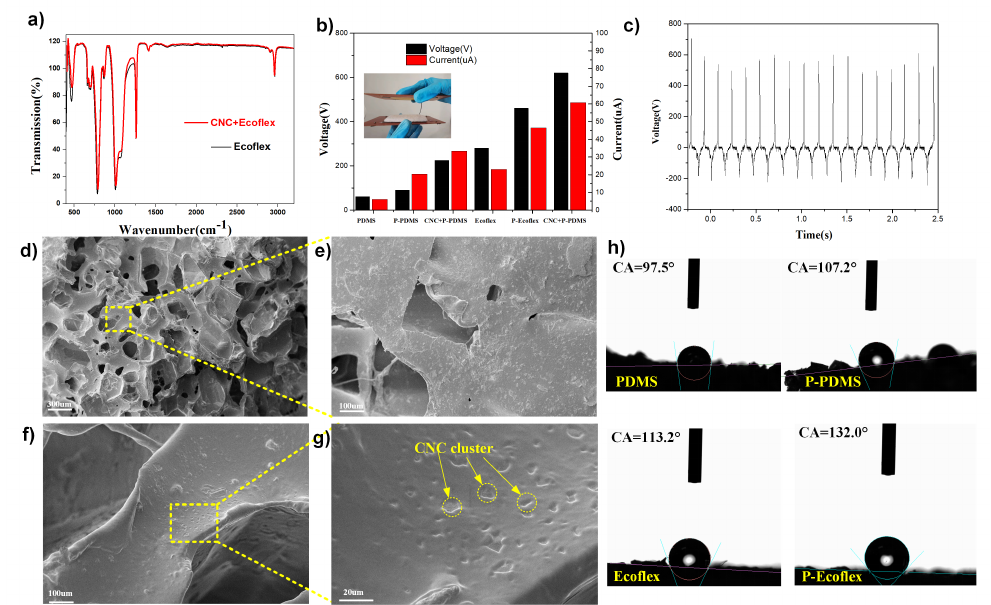
Figure 2. ( a ) FTIR spectra of the nanofiber-enhanced Eco and the original P-Eco samples; ( b ) his- togram comparison of different dielectric layer materials; ( c ) voltage output waveform of the CNC/P- Eco layer; ( d – g ) corresponding SEM images of the CNC/P-Eco sample; ( h ) the water contact angle of various silicone